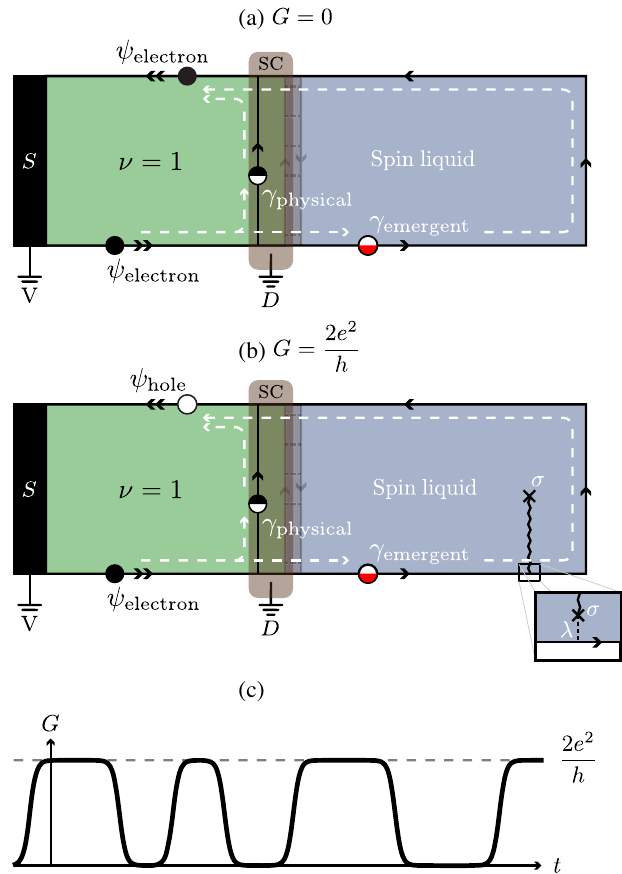
FIG. 9. (a),(b) Electrical detection of bulk Ising anyons via quantized zero-bias conductance G . Current flows from the source to the grounded superconductor. In (a), the spin liquid contains no Ising anyons in the bulk. Here, electrons injected at zero energy along the lower ν ¼ 1 edge splinter into physical and emergent Majorana fermions, but simply recombine into elec- trons at the upper ν ¼ 1 edge. No current flows into the superconductor and hence, G ¼ 0 . In (b), a pair of bulk Ising anyons is pulled out of the vacuum, with one of those anyons dragged to the gapless edge. Nontrivial mutual statistics between emergent fermions and the single remaining bulk Ising anyon causes incident zero-energy electrons to recombine perfectly into holes at the upper ν ¼ 1 edge. Each injected electron transmits a Cooper pair into the superconductor, yielding G ¼ ð 2 e 2 =h Þ . Enlargement: The Ising anyon dragged to the boundary couples to the chiral Majorana edge state with strength λ [see Eq. (32)]. (c) If random thermal processes toggle the system between configurations (a) and (b), G exhibits telegraph noise as a function of time, switching stochastically between G ¼ 0 and ð 2 e 2 =h Þ